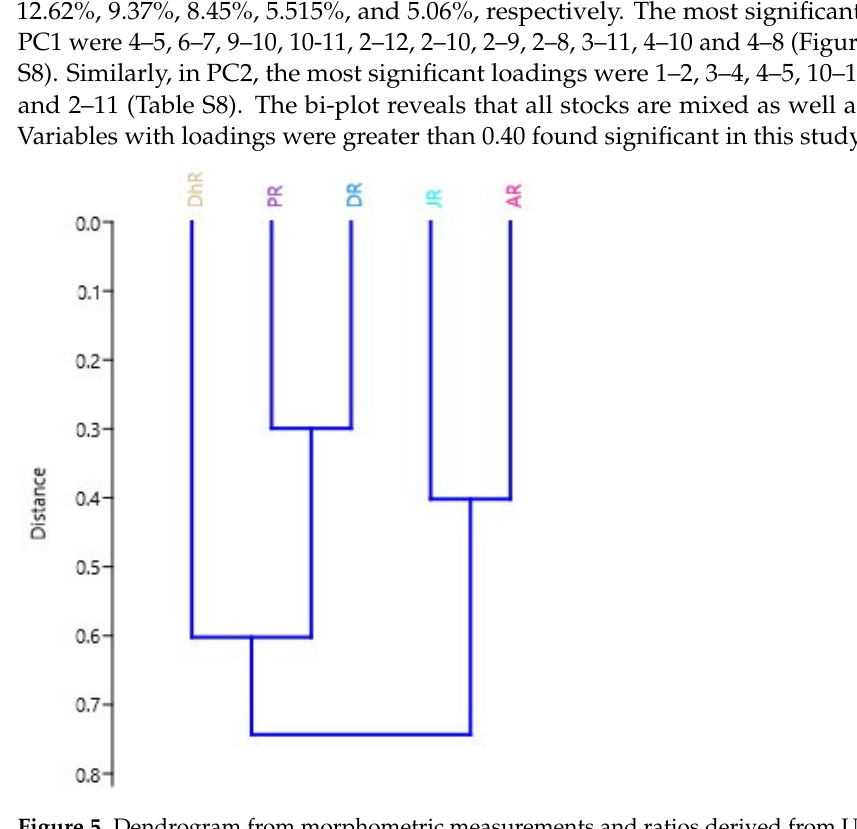
Figure 5. Dendrogram from morphometric measurements and ratios derived from UPGMA cluster analysis based on the Euclidean distance between the species centroids. In the figure, stocks areas are shortened as JR, Jamuna River; AR, Atrai River; DhR, Dhorala River; DR, Danu River, and PR, Padma River.